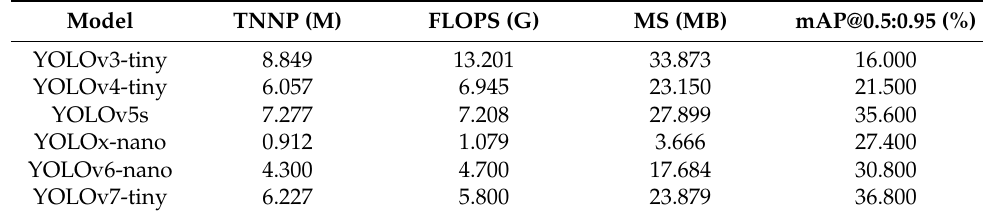
Table 2. Performance comparison of different pre-trained models for the same datasset.